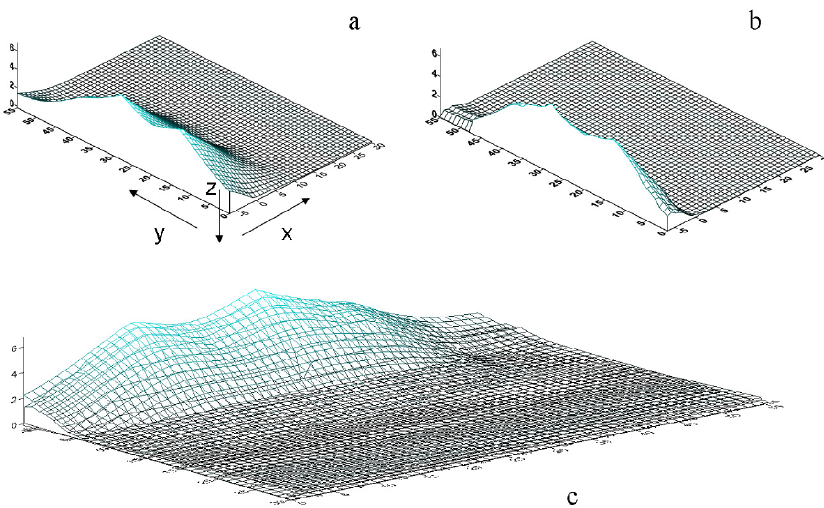
Figure 5. Sediment volume calculation by Golden Surfer (at 2 min under 25 mm/h rainfall intensity): ( a ) whole volume (sediment volume + initial slope volume); ( b ) initial slope volume; ( c ) using the whole volume to reduce the initial slope volume.